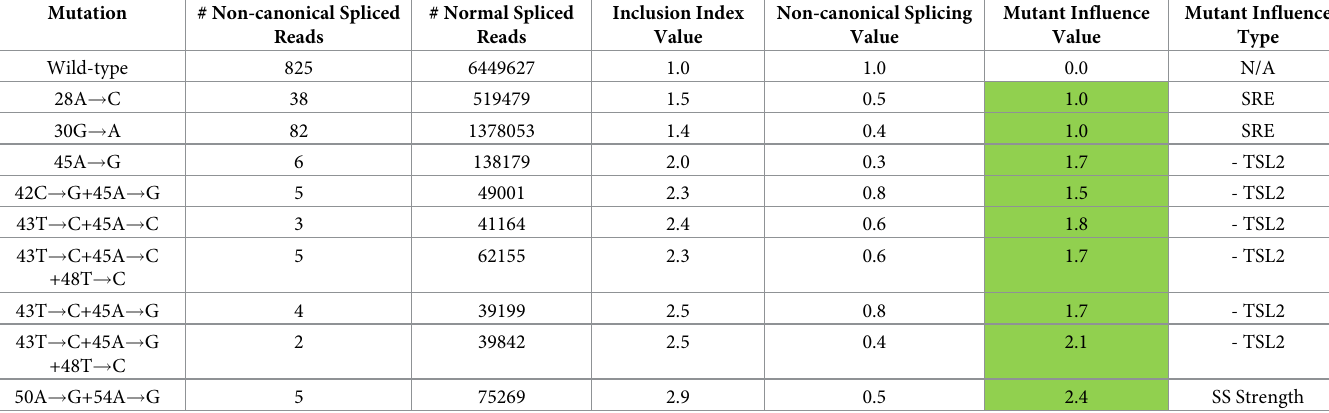
Mutant Influence Values are shaded green if the mutation selectively induces canonical splice site usage, white for no splice site preference and the red for non- canonical splice site preference. Significance is set at Benjamini-Hochberg FDR = 0.2. “SS Strength” refers to a change in splice site strength, “SRE” refers to the alteration of a splicing regulatory element, and “- TSL2” refers to the weakening of Terminal Stem Loop 2 within exon